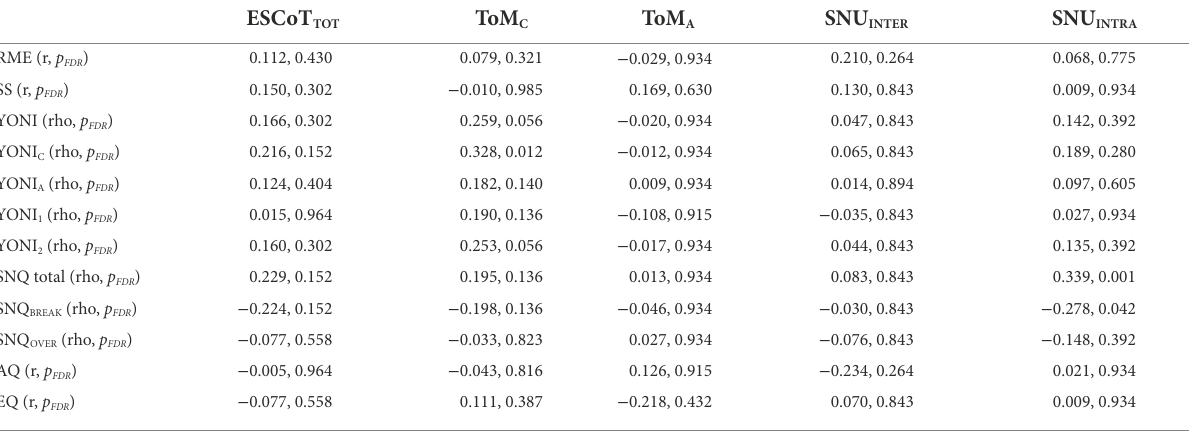
TABLE 2 Partial correlation analysis (covariate: the period of study participation—before or during the pandemic) between ESCoT subscores and social cognition tests. ESCoT TOT ToM C ToM A SNU INTER SNU INTRA